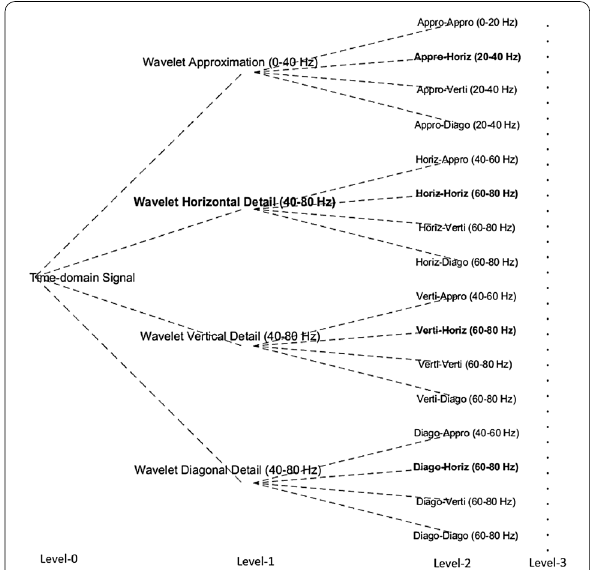
Fig. 2 The two‑dimensional wavelet packet decomposition tree; the best‑performing coefficients are highlighted with bold. The decomposition is performed up to Level‑3, which has been simplified for neat